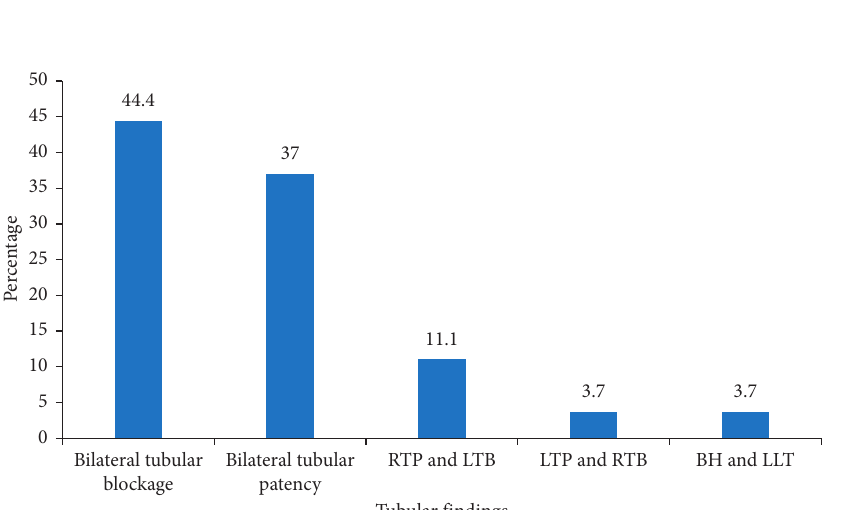
Figure 1: Distribution of tubal finding on HSG among 27 infertile women under ketamine sedation. RTP: right tubal patency; LTB: left tubal blockage; RTB: right tubal blockage; LTP: left tubal patency; BH: bilateral hydrosalpinx; LLT: leakage left